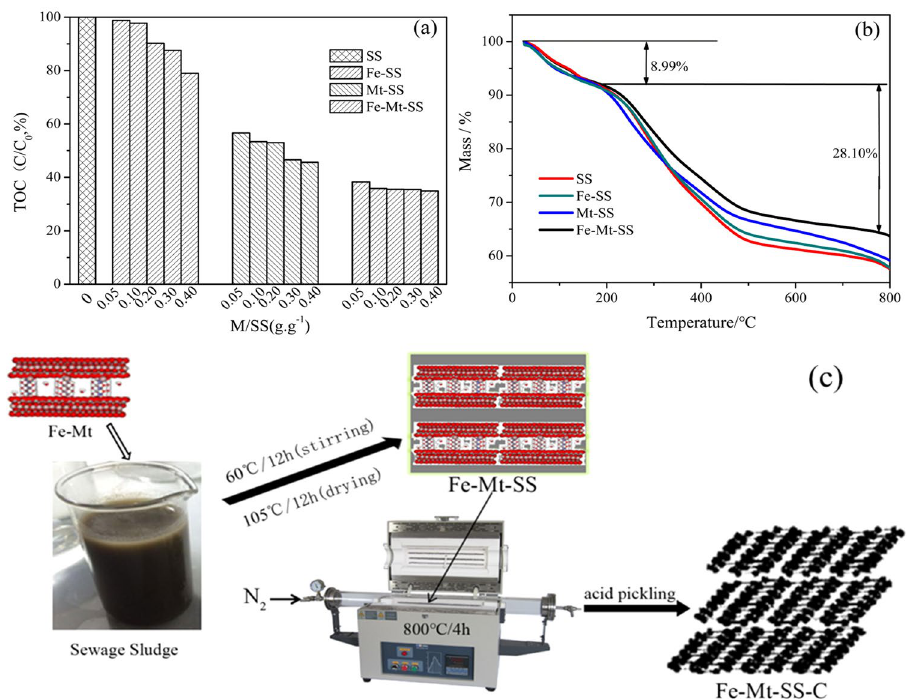
Figure 1. ( a ) TOC concentration of centrifugation from sewage sludge and after adding difference-proportion Mt, FeOOH and Fe-Mt, ( b ) TG curves of SS, Fe-SS, Mt-SS and Fe-Mt-SS, ( c ) schematic diagram of the preparation of the